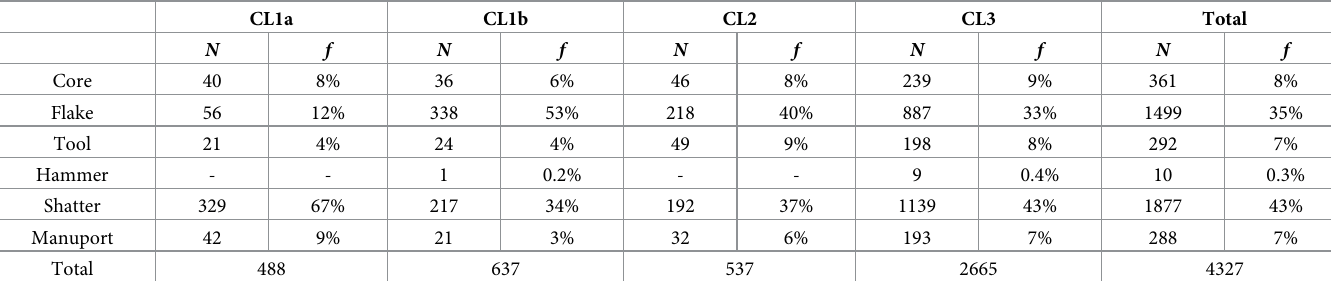
Table 1. The studied lithic sample of